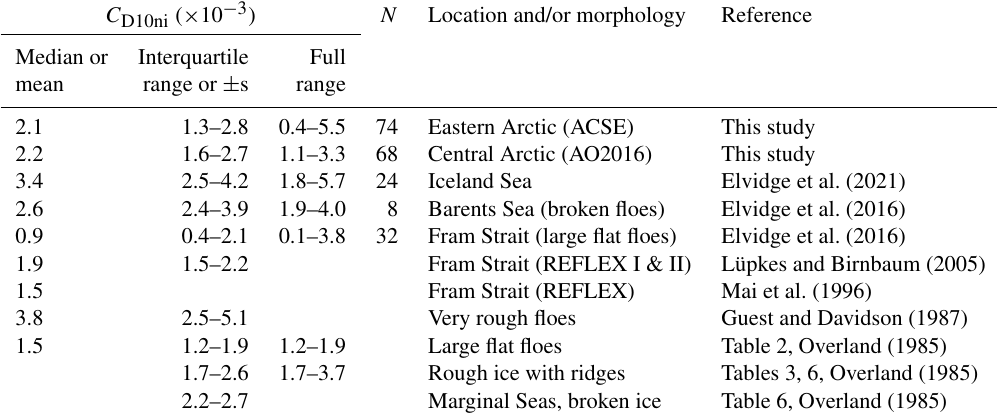
Table 2. Overview of neutral drag coefficients based on in situ eddy covariance measurements over “complete” sea-ice cover ( C D10ni ) from this and previous studies. The values are taken from the literature, and so vary as to whether the mean, median or a range of values is shown. The definition of “complete” sea ice covers a range of ice fractions (0.8–1, 0.9–1.0, and exactly 1) depending on the study. N is the number of data points in this bin where specified. The 2nd column provides the interquartile range or the range from − 1 to + 1s, where s is the standard deviation. Note Guest and Davidson (1987) uses the turbulence dissipation method. Overland (1985) compiles values from a variety of previous studies in various locations, as well as new data; thus, the values reproduced here are a compilation by morphology. C D10ni ( × 10 − 3 )